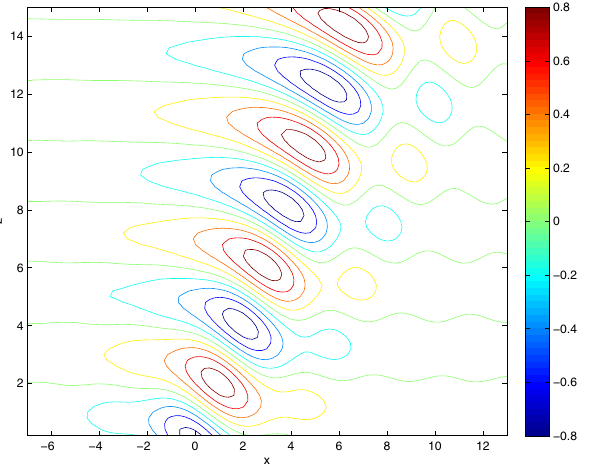
Figure 1. Contour plot of η for isothermal flow over a topography. Figure 2. Contour plot of η for non-isothermal flow over a topogra-